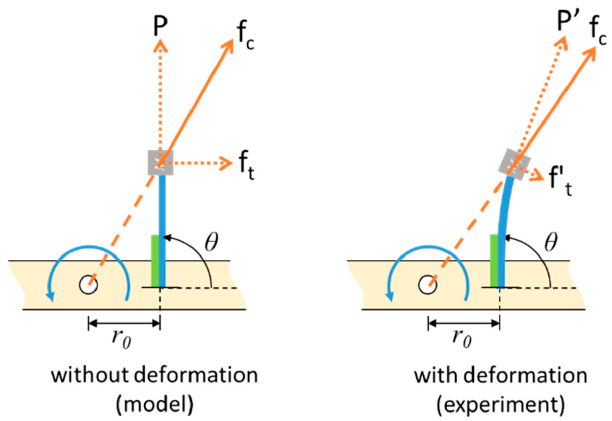
Figure 11. The illustration of axial load on the PEH in the tilted configuration.